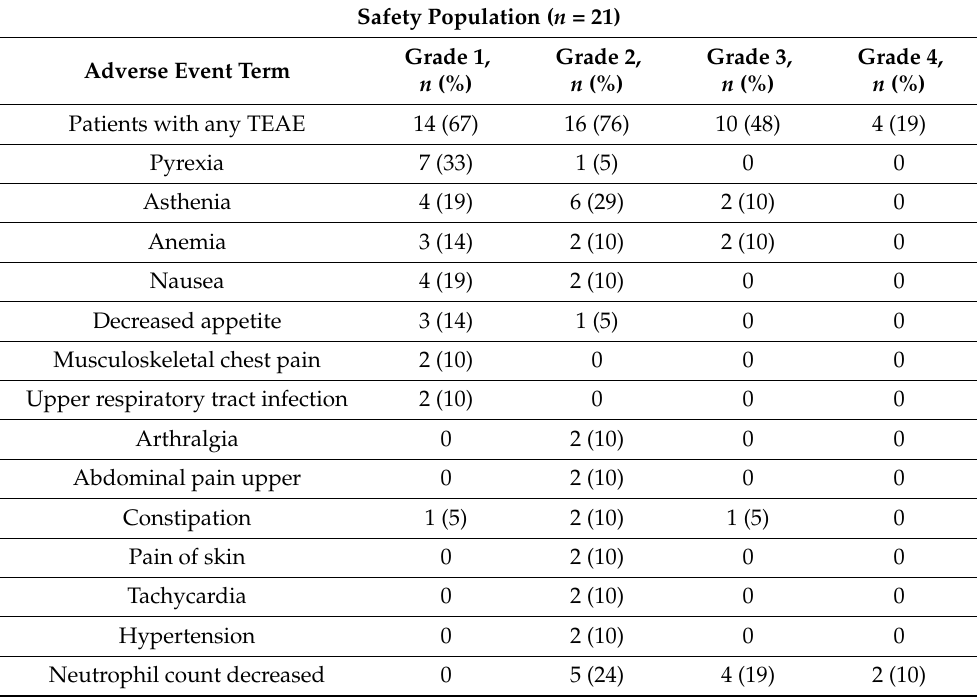
Table 2. Treatment-emergent adverse events by grade according to NCI-CTCAE (version 4.03) and frequency of at least 5% in any grade.